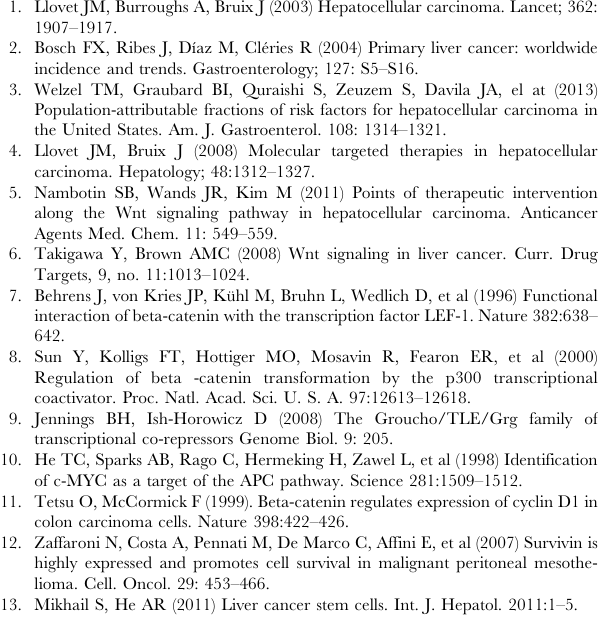
Figure S3 Huh7 cells were plated to 96 well plates at 2500 cells/